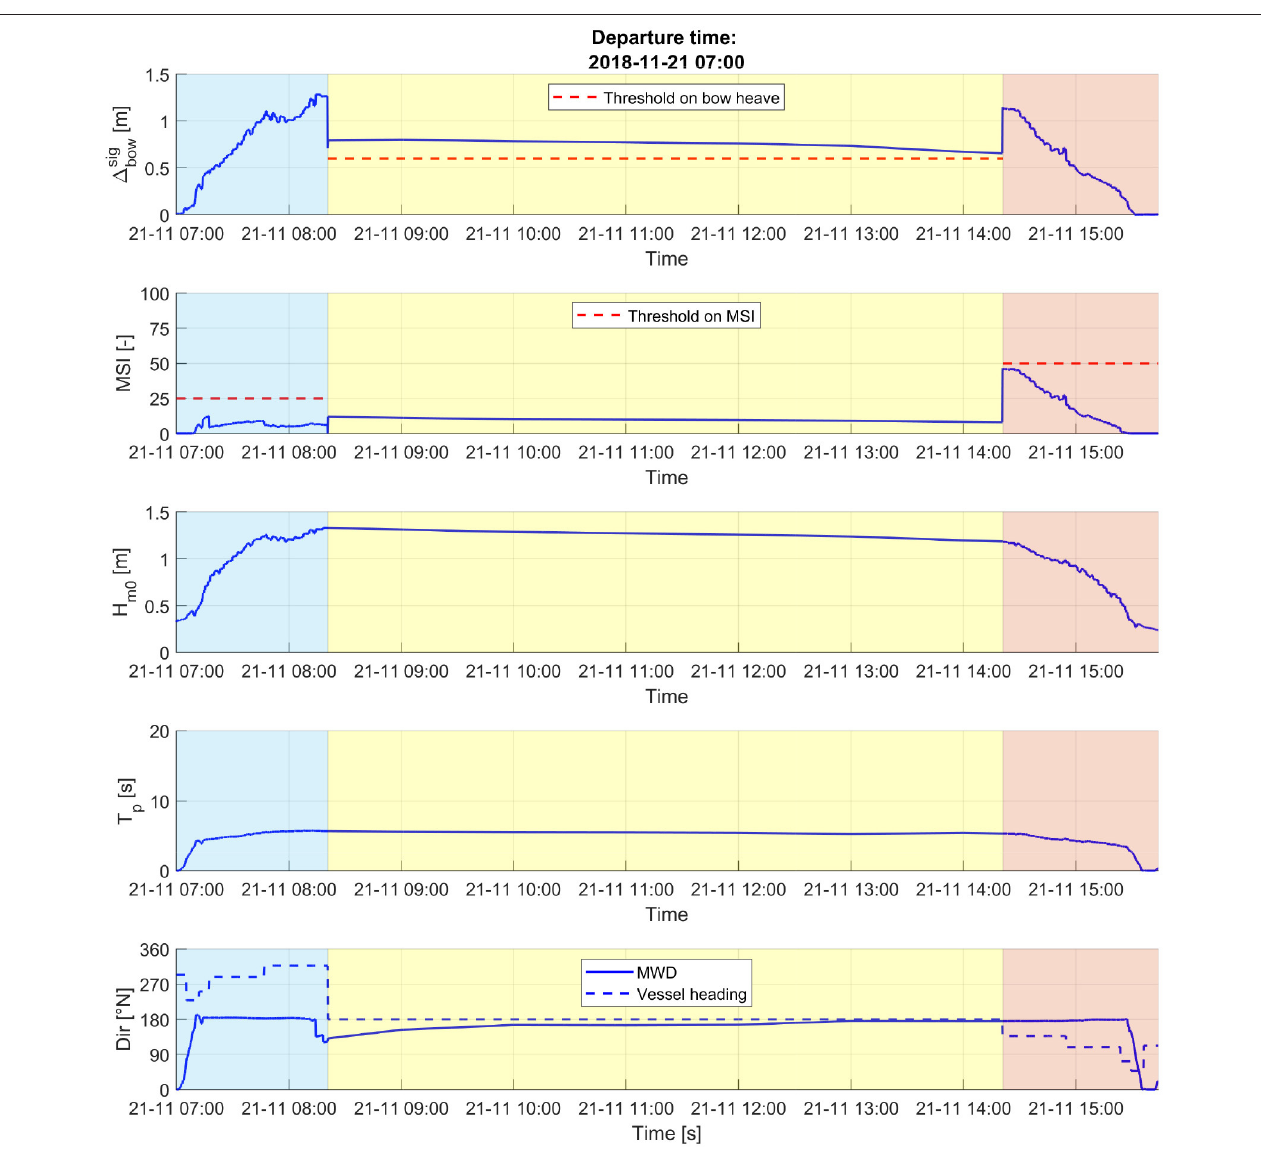
FIGURE 8 | Output for the trip departed on the 21st of November 2018 at 07:00. From top to bottom panel: significant vertical displacement of the bow ( 1 sig bow ), Motion Sickness Incidence (MSI), combined significant wave height (sea and swell), swell peak wave period, and swell mean wave direction. Bottom panel displays also the CTV direction. In each plot, the time window for each phase is marked with a different color, i.e., cyan for sail-out, yellow for operation, pink for